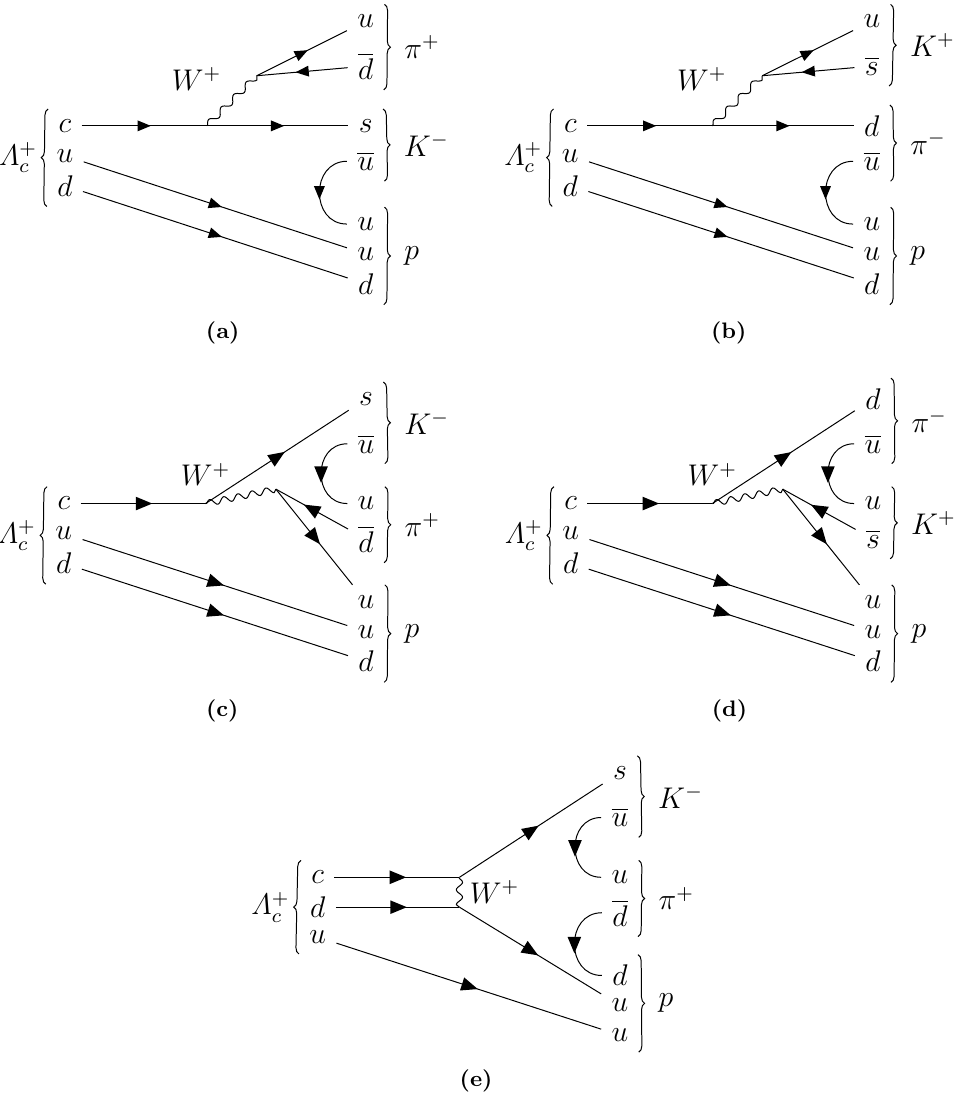
Figure 1 . Weak decays of (cid:3) + are external W -emission for (a) (cid:3) + (c) (cid:3) + ! pK (cid:0) (cid:25) + and (d) (cid:3) + c